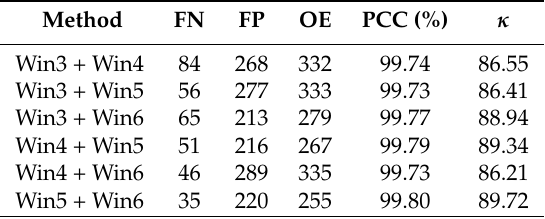
Table 8. Evaluation values of different sizes of fused blocks of the coastline data set.